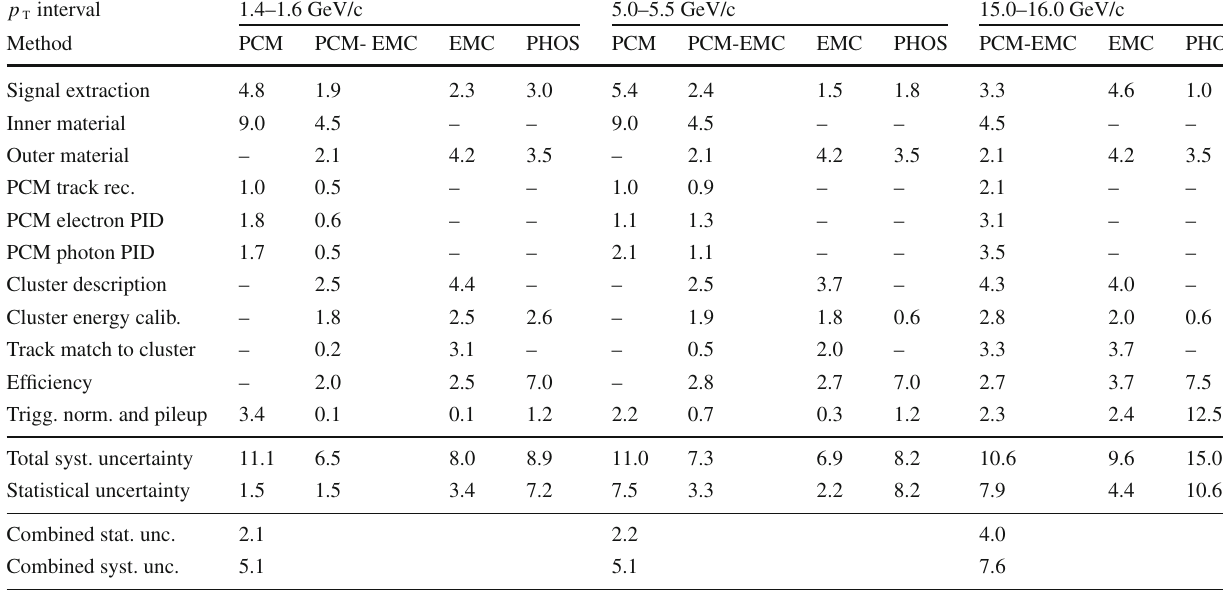
forallreconstructionmethodsavailableinthegiven p T bin,considering the uncertainty correlations for the different methods (see Sect. 6 for further details). The uncertainty from σ MB determination of 2.6%, AND see Ref. [35], is independent from the reported measurements and is separately indicated in the following plots